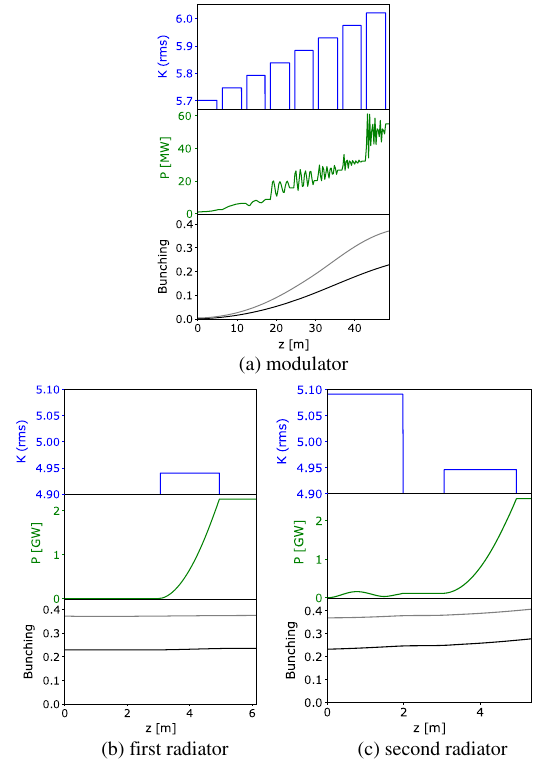
FIG. 8. Growth of the radiation power and the electron beam bunching (grey line — peak value, black line — current-weighted average) as a function of the undulator length.